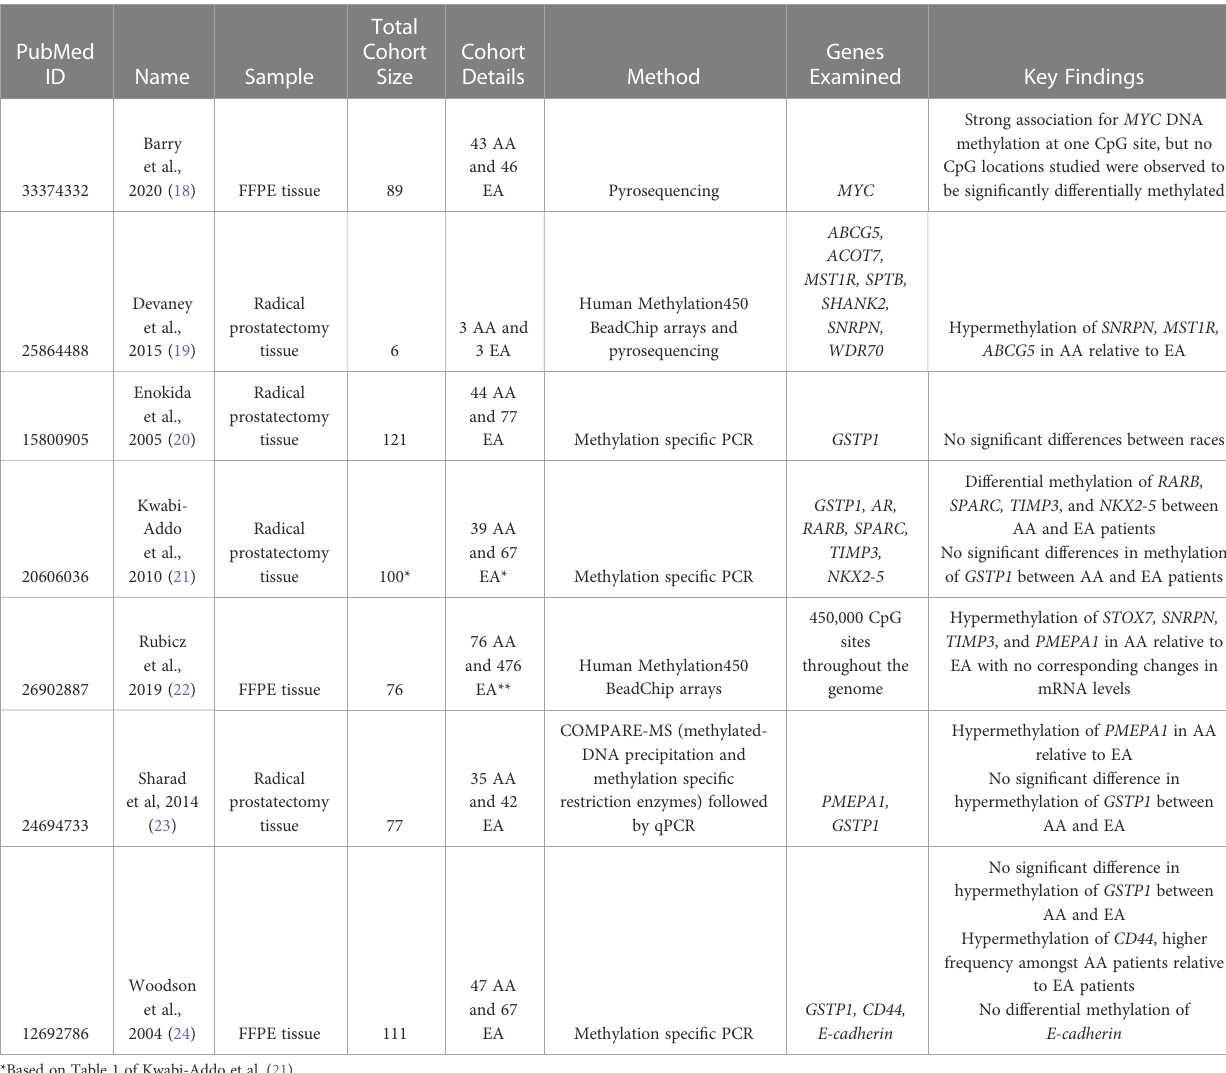
TABLE 2 Studies that compared DNA methylation features between AA and EA patients.